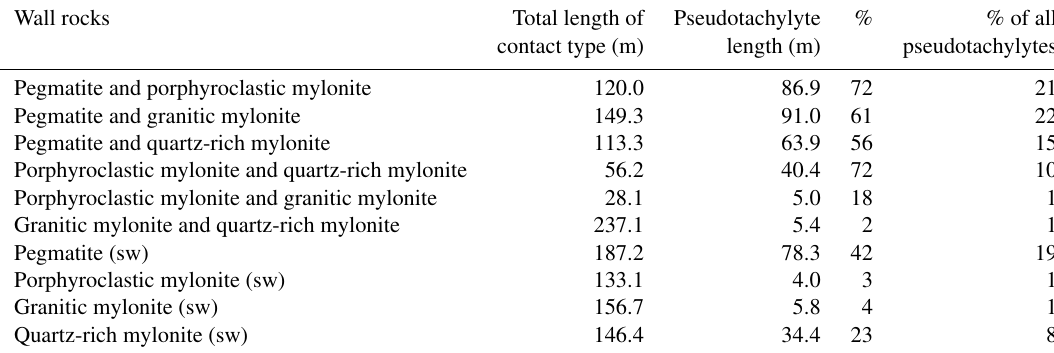
Table 2. Total length of contacts in mapped area, categorised by the lithologies juxtaposed across the contacts (similar on either side of pseudotachylyte (sw) or different wall rocks), with percentage of total length by wall rock lithology which is decorated by pseudotachylyte. Rows ordered by apparent relative